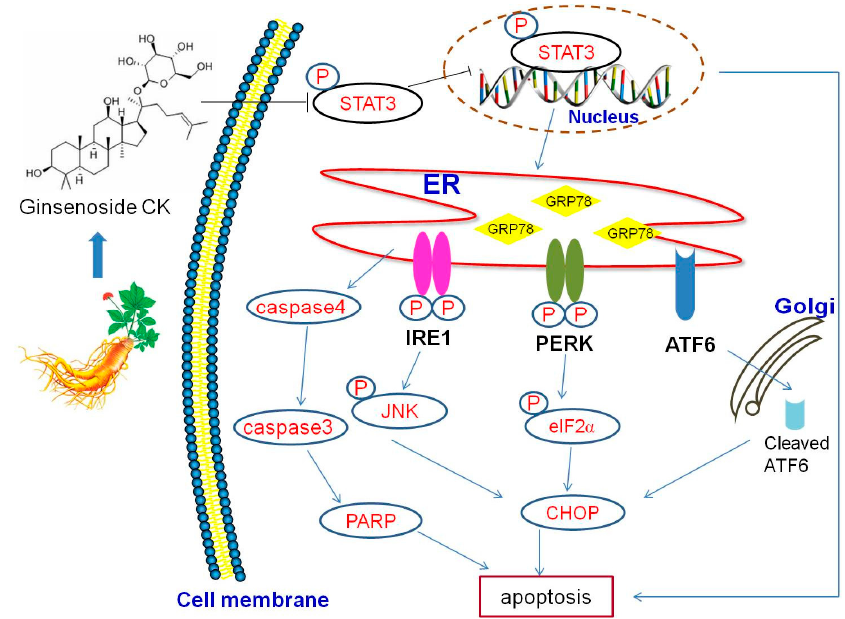
Figure 7. Schematic illustration of the potential pathway underlying the anticancer activity of CK in human HCC cells.